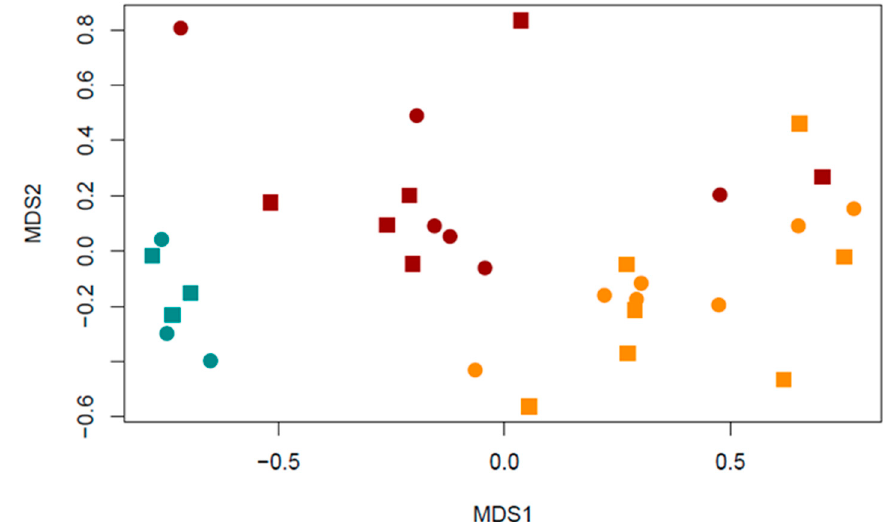
Figure 2. The Pesquer í a River non-metric multidimensional scaling (NMDS) based on square root relative abundances and Bray–Curtis distance. (NMDS stress value = 0.13). All the sampling sites represented by “square” are from the wet season sampling campaign and “circle” is used for the dry season sampling campaign. Each land use class is represented, with natural in blue, urban in dark red, and agricultural in orange.